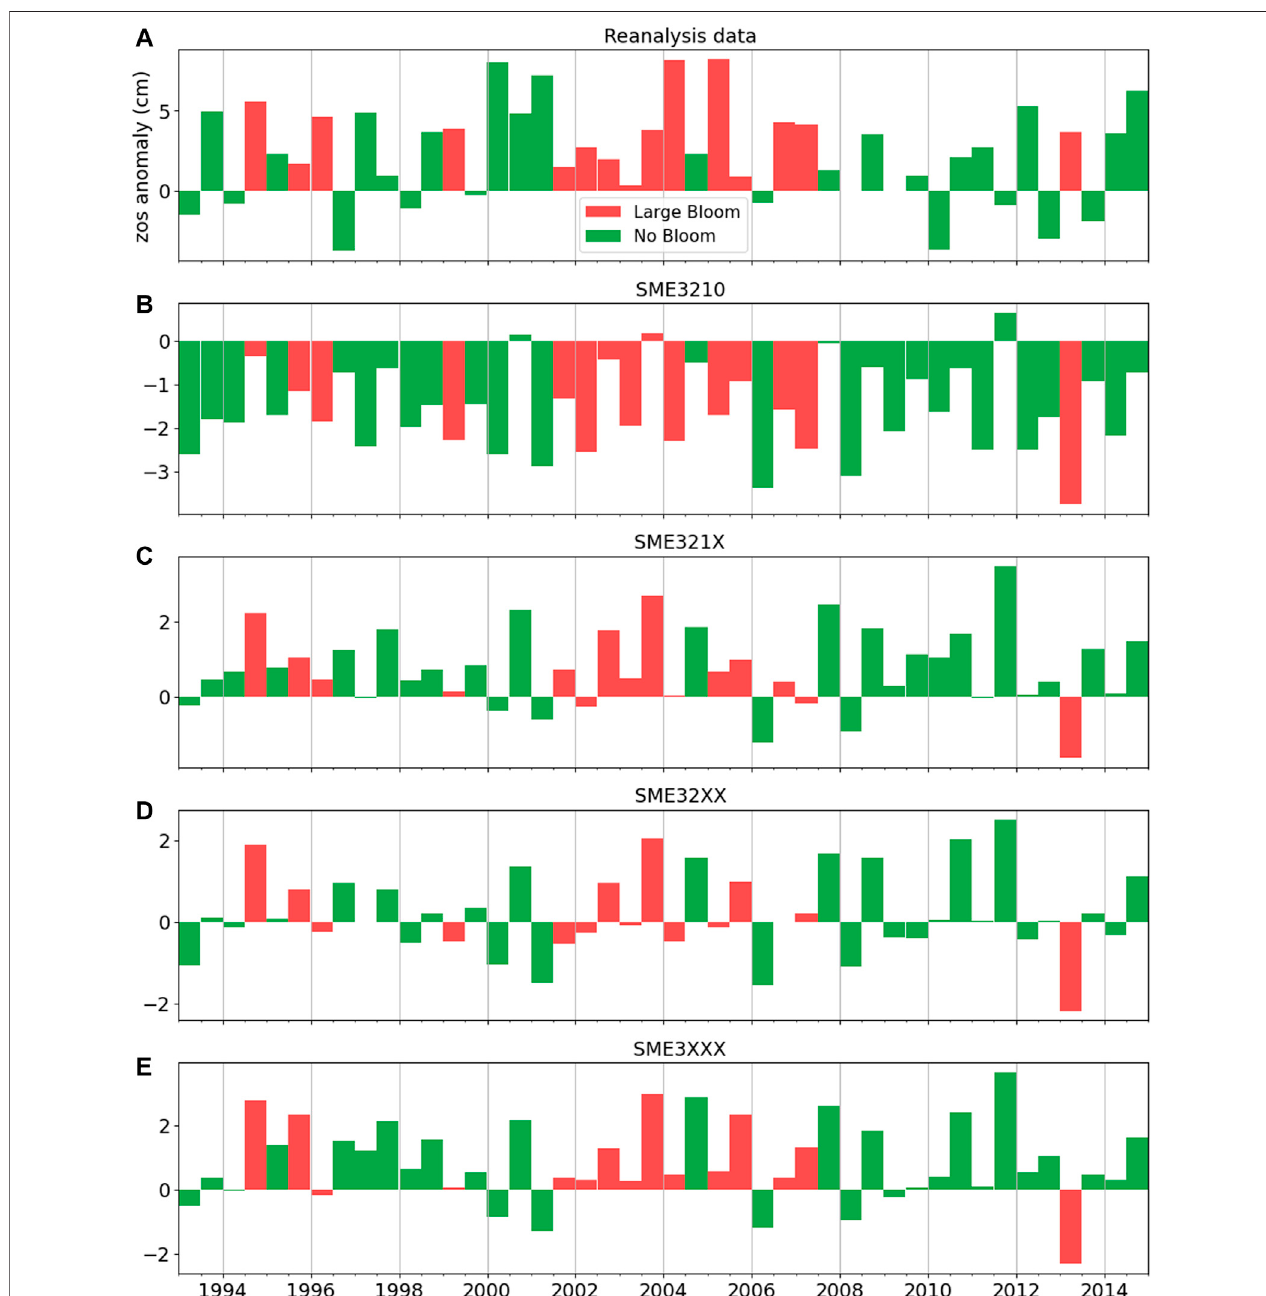
FIGURE6| Temporalmatchoflargebloom/nobloomwithLoopCurrentpositionsgiventhesurfaceheightabovegeoid(zos)anomaly( Eq.5 )of (A) reanalysisdata, and (B – E) simulations of four multi-model ensembles. Positive and negative bars indicate Loop Current North (LC-N) and Loop Current South (LC-S), respectively.